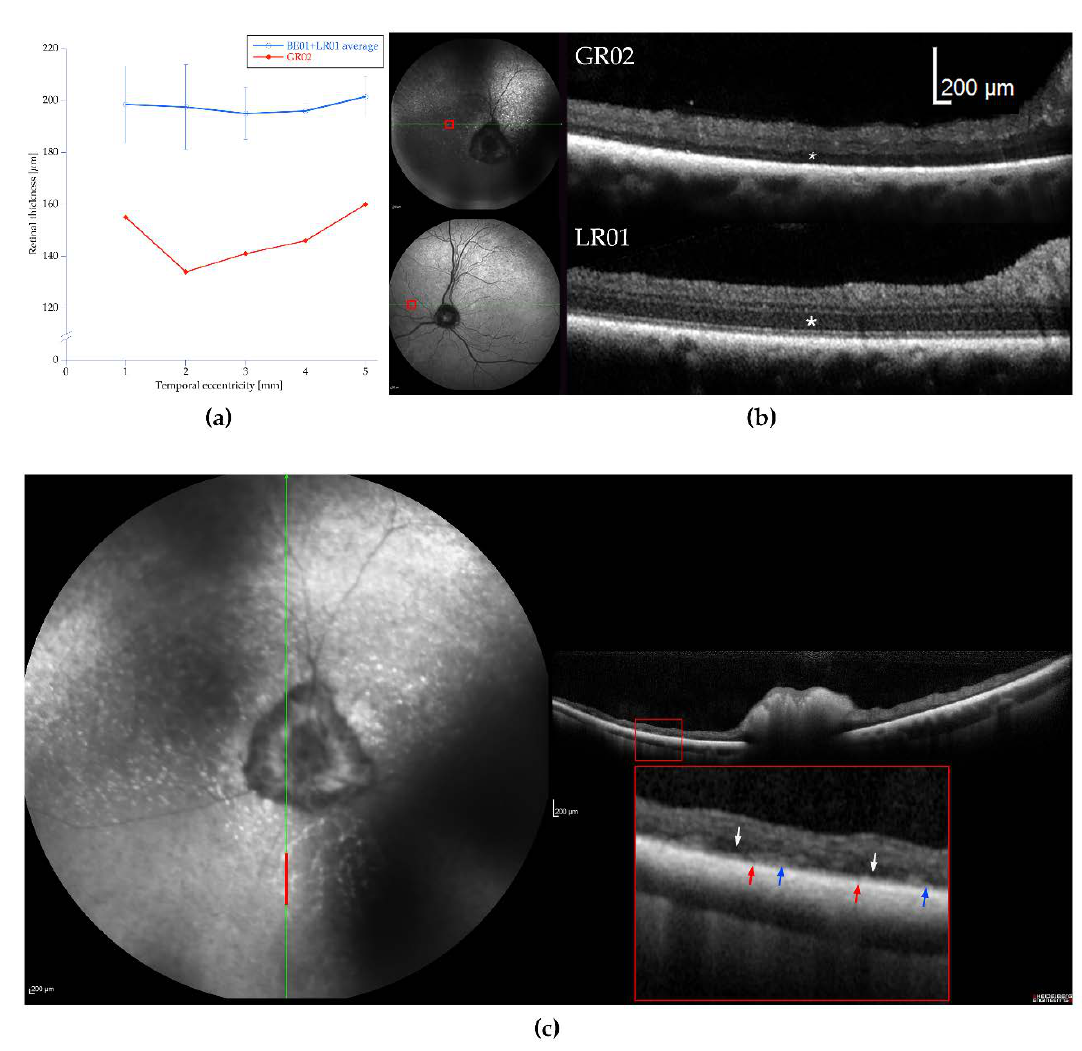
Figure 2. Retinal thickness and optical coherence tomography (OCT). ( a ) Total retinal thickness temporally from the optic nerve head (ONH) towards the periphery of the retina is reduced in the a ff ected dog (GR02) compared to the thickness observed in an una ff ected Labrador retriever (LR01) and a Beagle (BE01). ( b ) OCTs from the nasal part of the fundus (red rectangles) from the a ff ected dog (GR02, top) and the una ff ected dog (LR01, bottom) showing both the marked thinning of the outer nuclear layer (ONL) (asterisk) and less distinct segmentation of retinal layers in the a ff ected dog. ( c ) Appearance of the retina in the non-tapetal, ventral fundus of GR02. The vertical red bar in the cSLO-image shows the area outlined by the red rectangle on the OCT photograph, which is then magnified below (the area inside the large red rectangle). Cast shadows on the cSLO-image were caused by cataracts. The thinned retina is more variable in thickness than in the tapetal fundus dorsal to the ONH. The retinal pigment epithelium (RPE) is occasionally fragmented (red arrows) or appears thickened (blue arrows). The segmentation of the outer retina is di ffi cult and dark areas probably representing clusters of nuclei in the ONL are seen occasionally (white arrows).